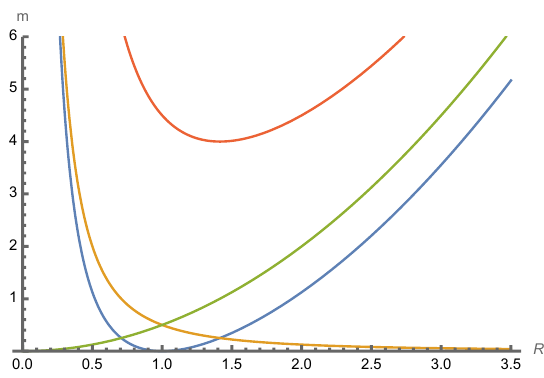
Figure 1 . Mass behavior (in string units) of different BPS states in terms of the circle radius for a 9d theory with 16 supercharges (heterotic on S 1 with Wilson lines switched off). The blue, red, yellow and green curves denote masses of field theory, black hole, and the two infinite distance light towers